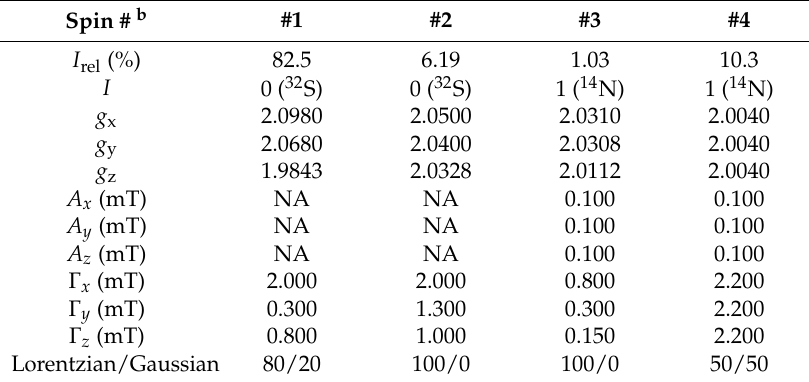
Table A2. Parameters for simulated spectrum of δ -salt under dark conditions a .